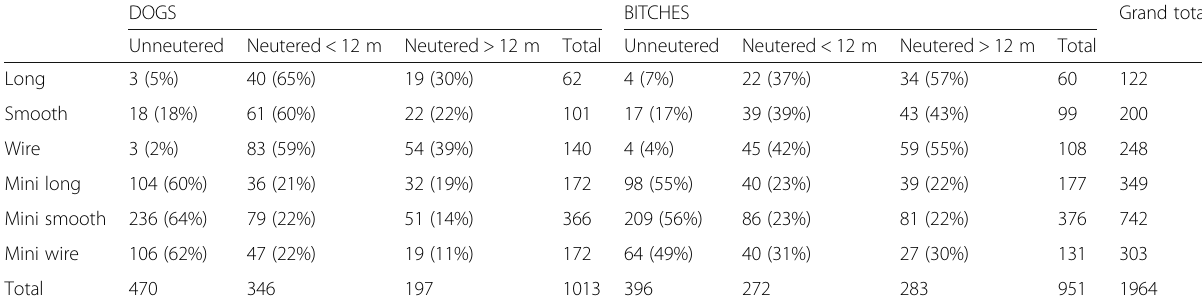
Table 2 Animals in the study population as described by gender, neuter age, and dachshund variety DOGS BITCHES Grand